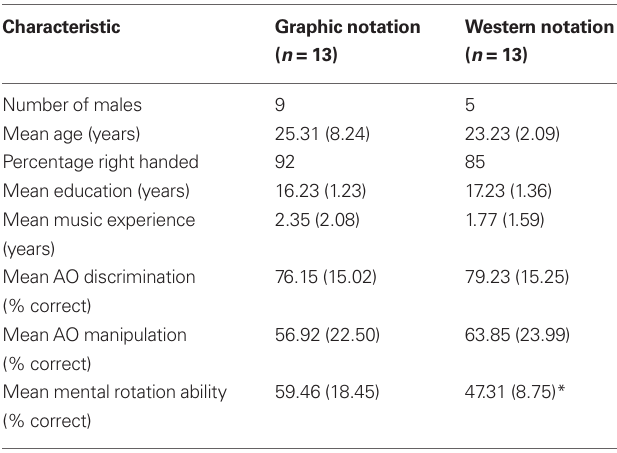
Table 8 | Demographic and baseline characteristics of the groups in experiment 2 ( ± sD).